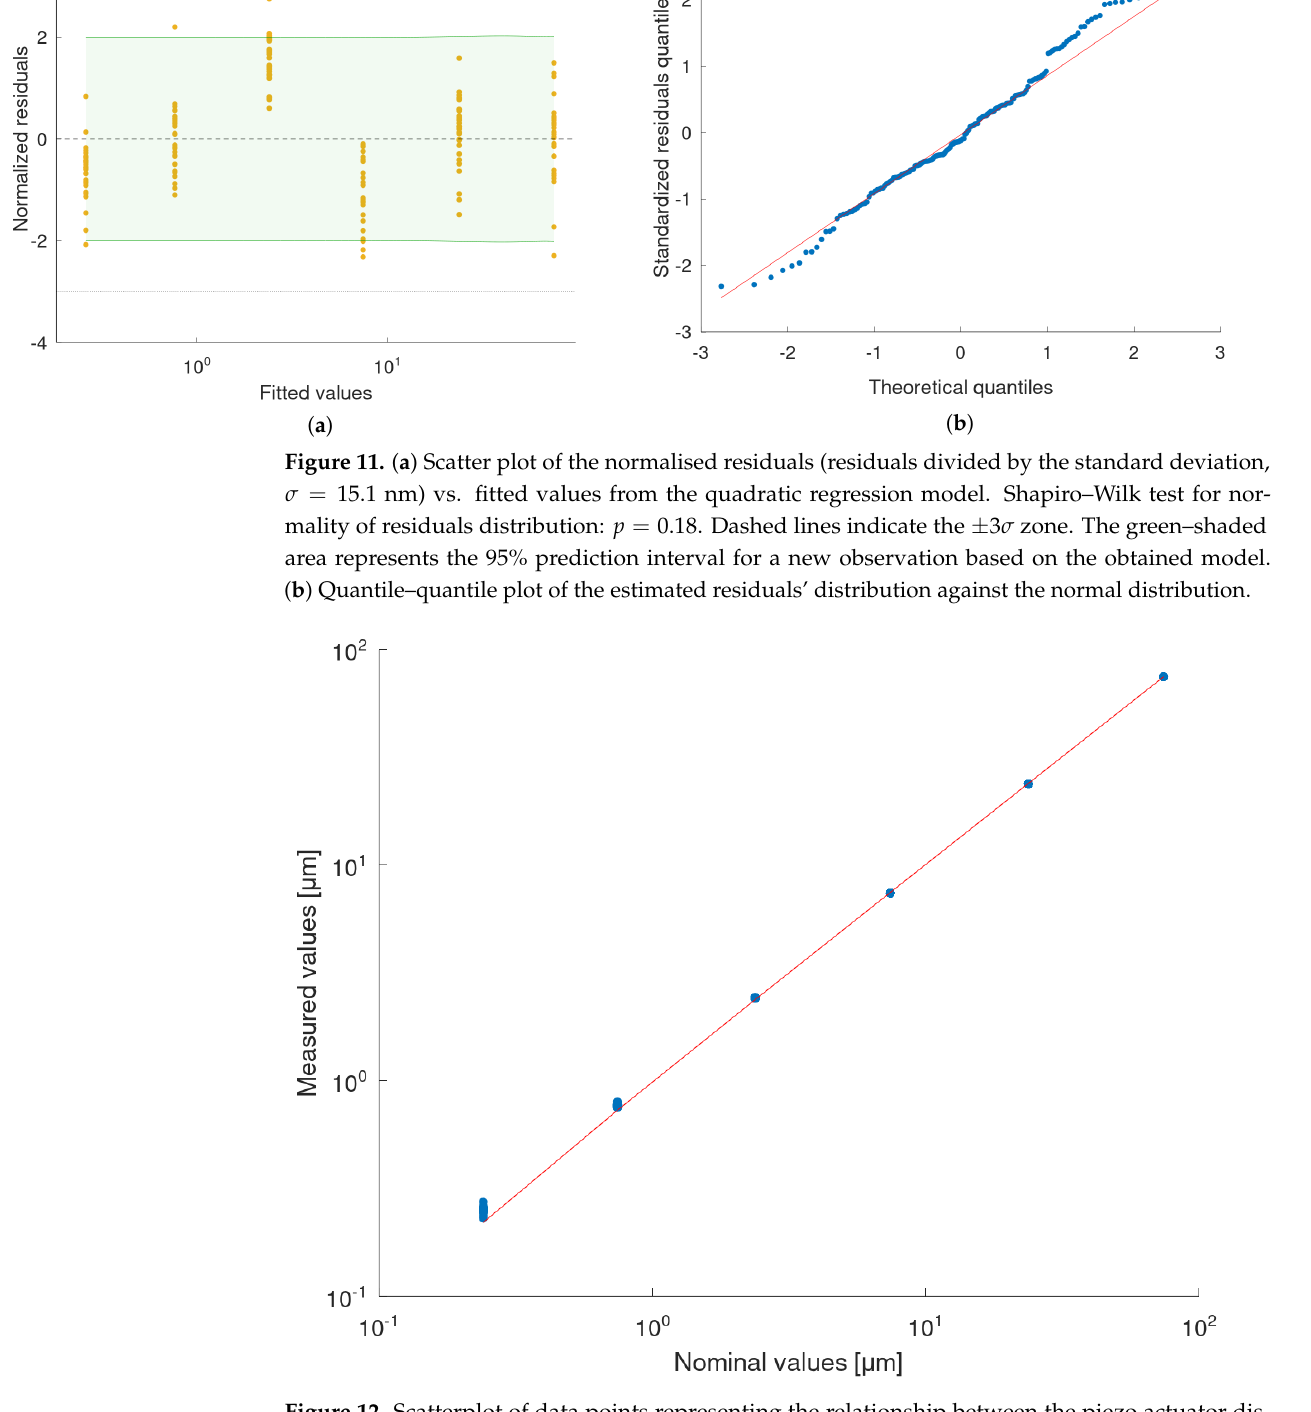
Figure 12. Scatterplot of data points representing the relationship between the piezo actuator dis- placement (estimated based on the required displacement and the calibration linear model obtained with the XL-80 interferometer) and the displacement being measured with the Taylor Hobson 130. The linear regression model is fitted (1 − R 2 = 4.9 × 10 − 6 ), slope: 1.008956, intercept: − 0.023186 µ